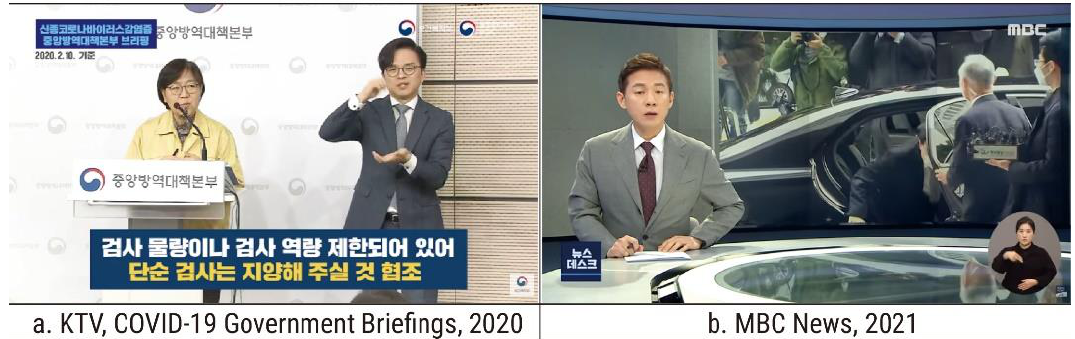
Figure 1. Samples of sign language services in TV broadcasting in Korea. Translation of subtitle – Left: “Please refrain from simple inspections due to limited inspection volume and inspection capabilities ” .